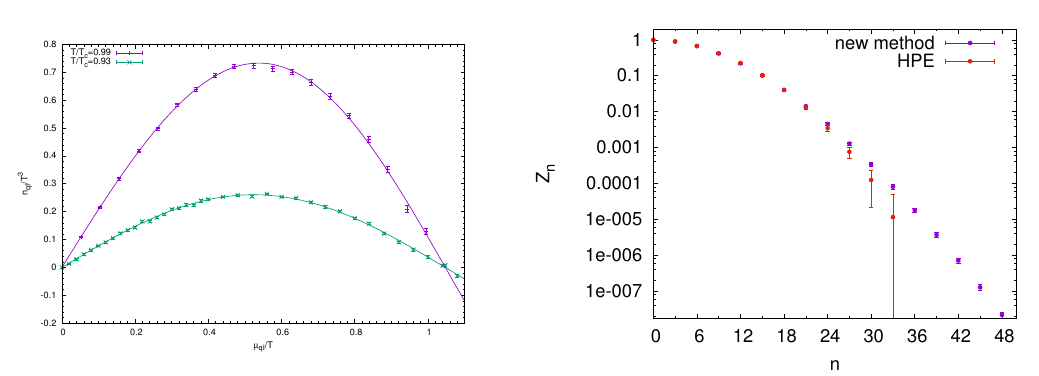
Figure 1. Imaginary density as a function of θ for two temperatures in the confining phase. The curves show fits to the function (9) with n max = 1 for T / T c = 0 . 93 and n max = 2 for T / T c = 0 . 99.